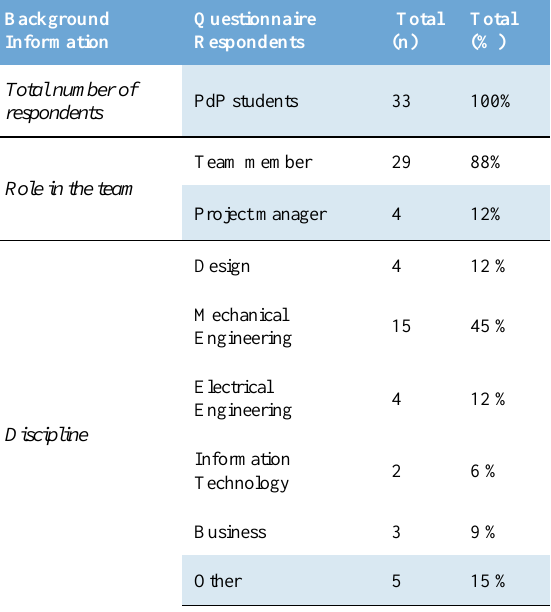
Table 1. Background information of the respondents.